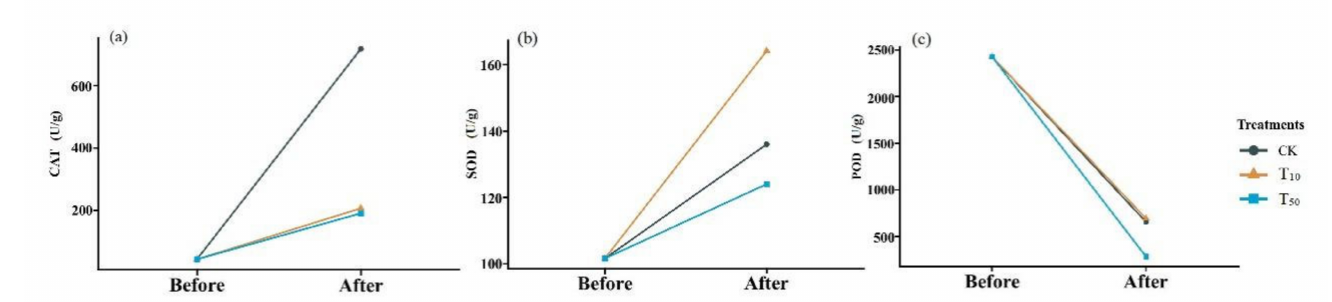
Figure 3. Changes in catalase ( a ), superoxide dismutase ( b ), and peroxidase ( c ) in earthworms before and after conversion. CK, T 10 , and T 50 represent treatment groups with 0, 10, and 50 mg/kg arsenic added, respectively.